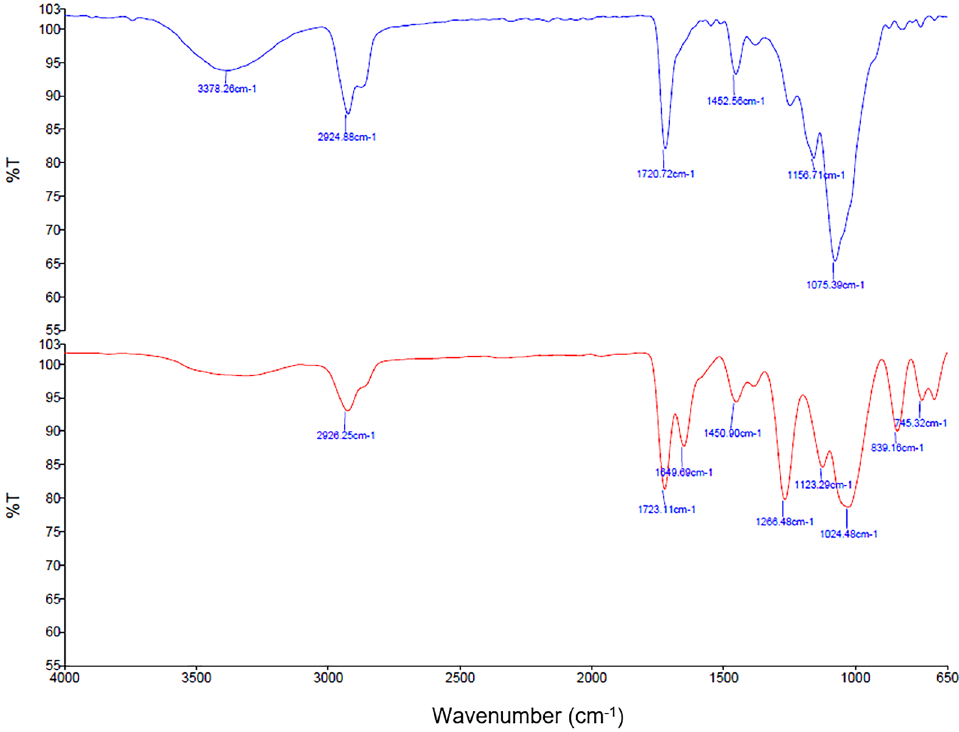
Figure 9. ATR-FTIR spectra comparison of the reverse area of genuine (blue spectrum) and counterfeit (red spectrum) RM50